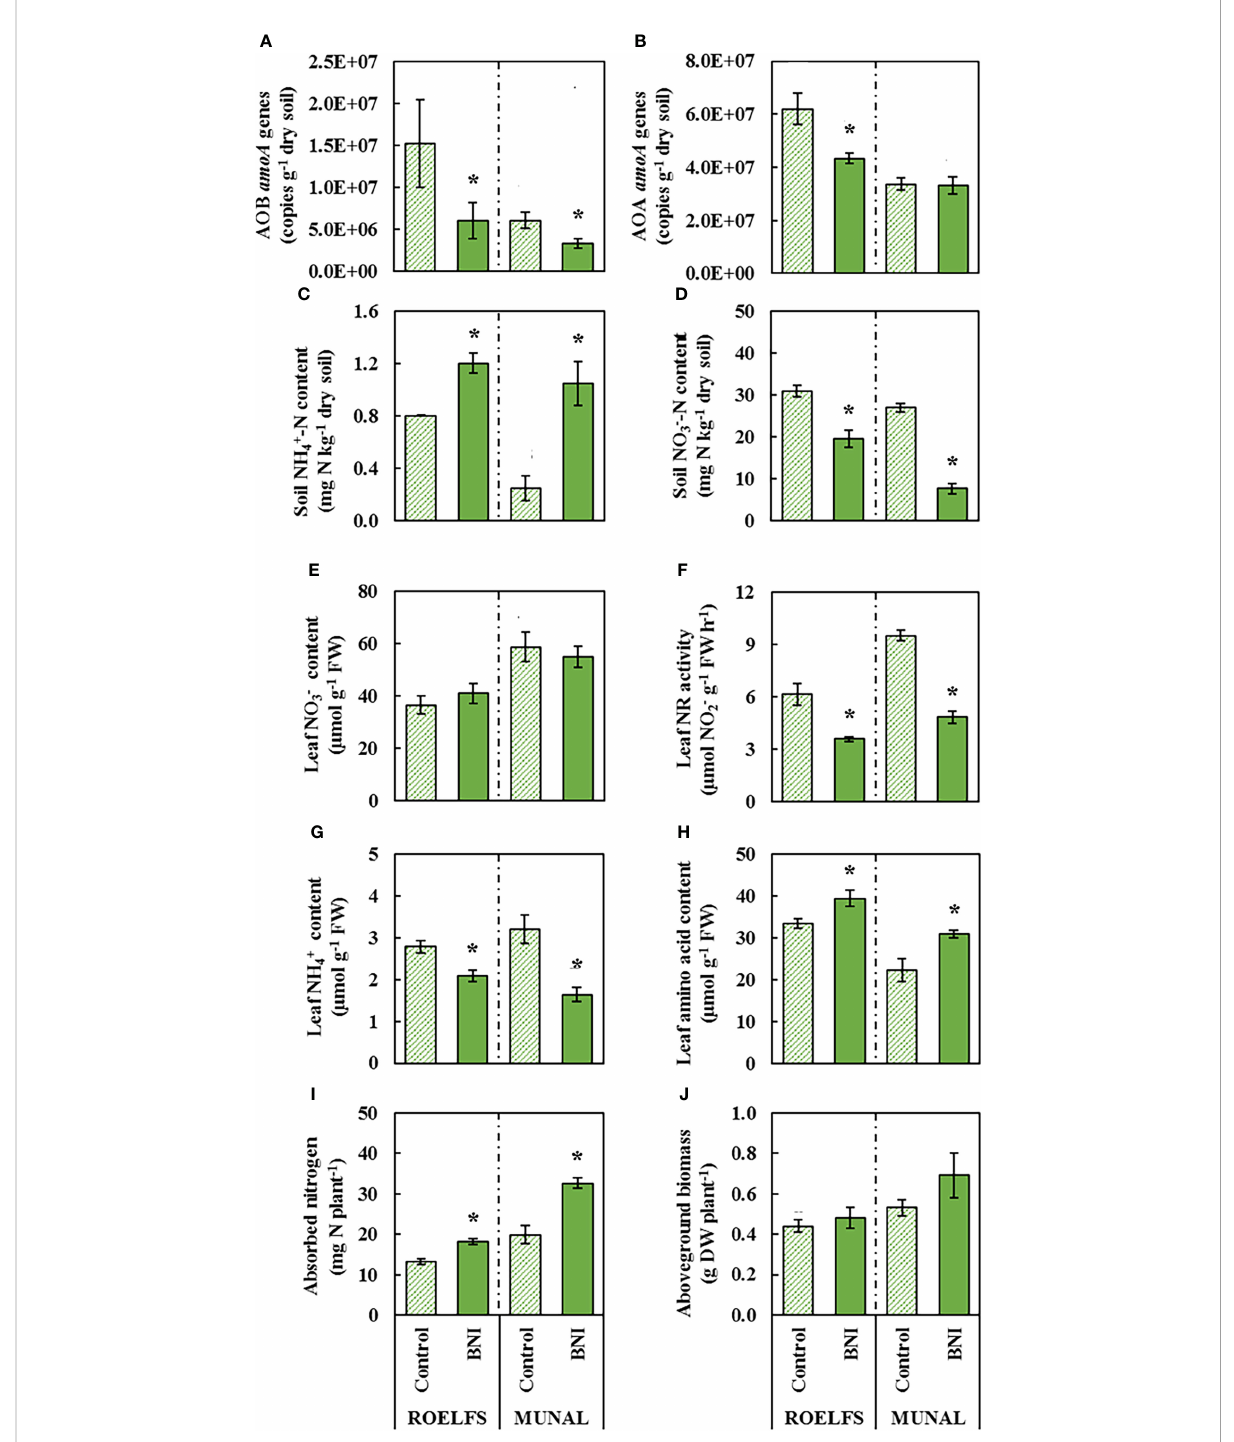
FIGURE 2 Performance of Control and BNI-isogenic-lines from ROELFS and MUNAL fertilized with ammonium sulphate (AS) . Soil and plant parameters were measured 30 days post-fertilization (T30): Abundance of AOB (A) and AOA (B) , soil mineral nitrogen content such as ammonium (C) and nitrate (D) , and leaf determination of nitrate content (E) , nitrate reductase activity (F) , ammonium content (G) , amino acid content (H) , absorbed nitrogen (I) , and aboveground biomass (J) . The Mann-Whitney U test was used for the comparison between the absence or the presence of BNI-trait and the signi fi cant differences at p <0.05 are marked with an asterisk